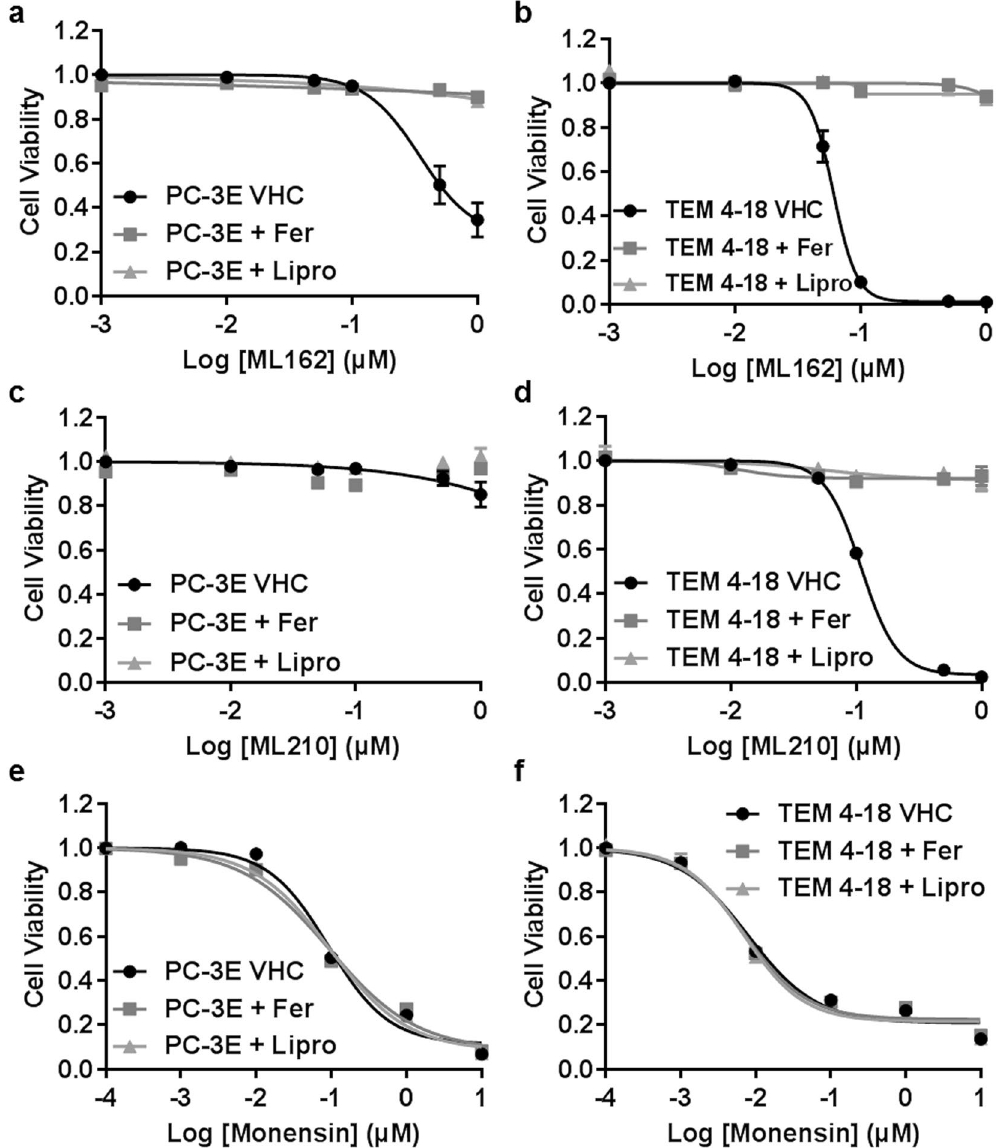
Figure 5. Monensin and GPX4 inhibitor EMT-selective toxicity involves different mechanisms. Cells were treated for 72 h with serial dilution of ML162 ( a , b ), ML210 ( c , d ) or monensin ( e , f ) alone or in combination with vehicle (VHC) ferrostatin 2 µ M (Fer), or liproxstatin 0.5 µ M (Lipro). Relative cell viability was plotted against the logarithm of drug concentration. The results represent the means ± SEM (n =